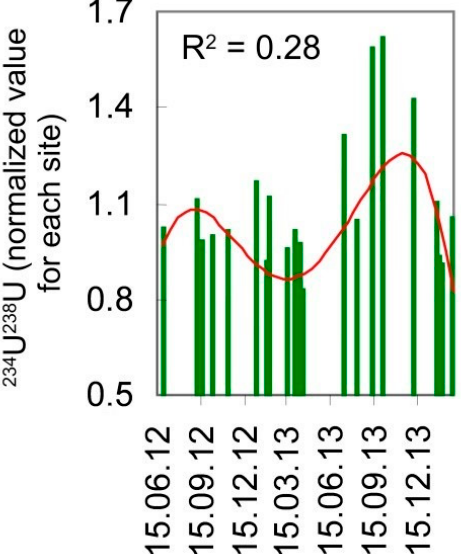
Figure 5. Change in the isotopic composition of uranium ( 234 U/ 238 U) of surface (5 monitoring points) and groundwater (36 monitoring points) of the Kultuk test site, southern Baikal region (data from Table 1 after [122]): the 234 U/ 238 U ratio is normalized to the average for each sampling point, and the curve is a polynomial of degree four, which gives the first best approximation in R 2 (more reliable detection of seasonal variations is hindered by the uneven sampling of water in time).